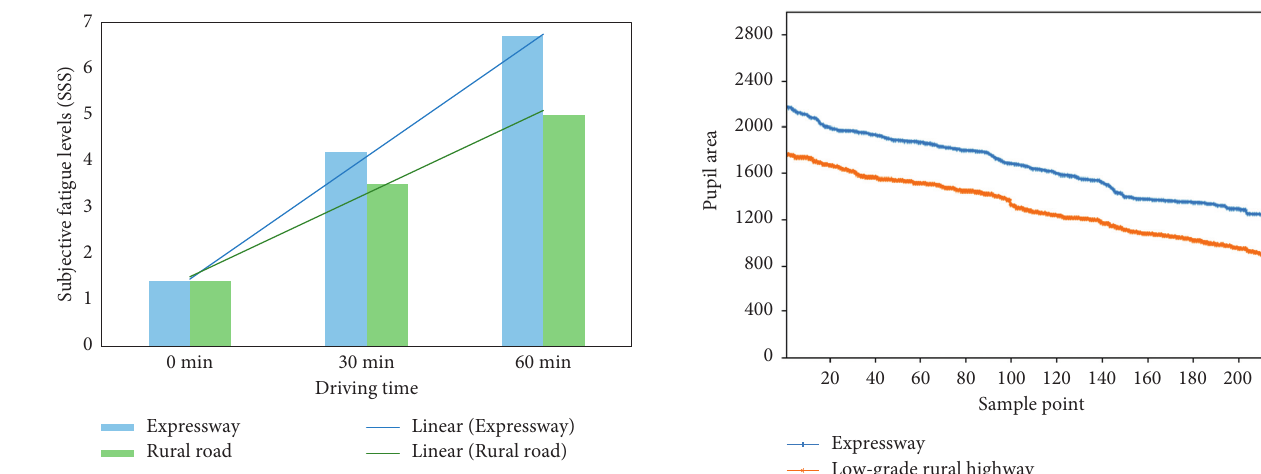
Figure 6: Subjective fatigue state value of